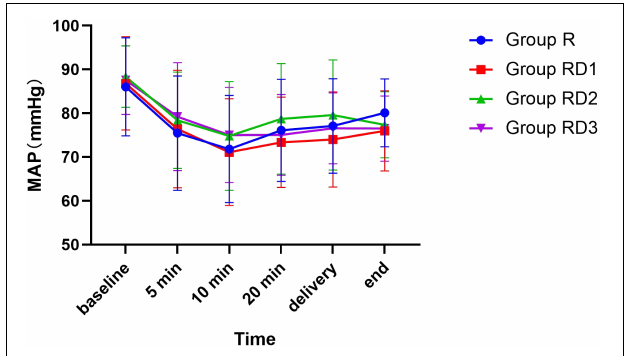
FIGURE 4 | SPO 2 among the four groups. No significant differences were noted between the groups.